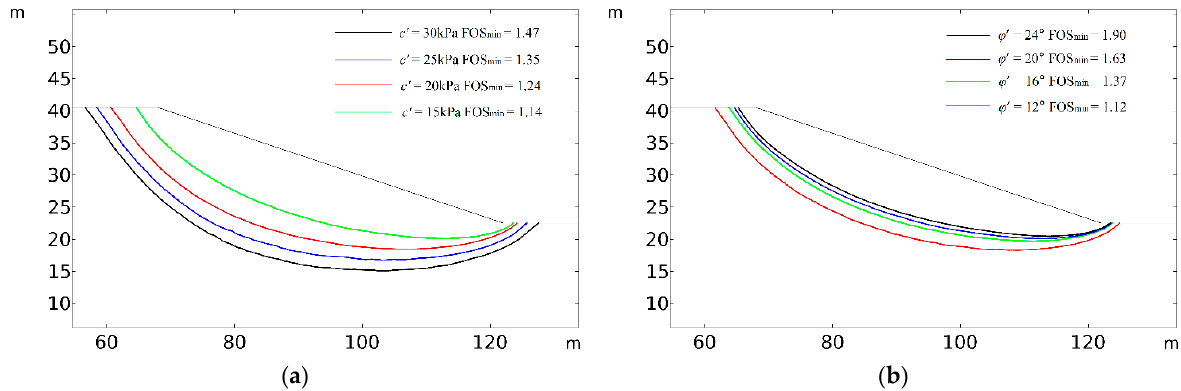
Figure 7. Destruction areas of the slope with different soil parameters: ( a ) c ’ = 15 kPa, 20 kPa, 25 kPa, 30 kPa; ( b ) φ ’ = 12°, 16°, 20°, 24°.